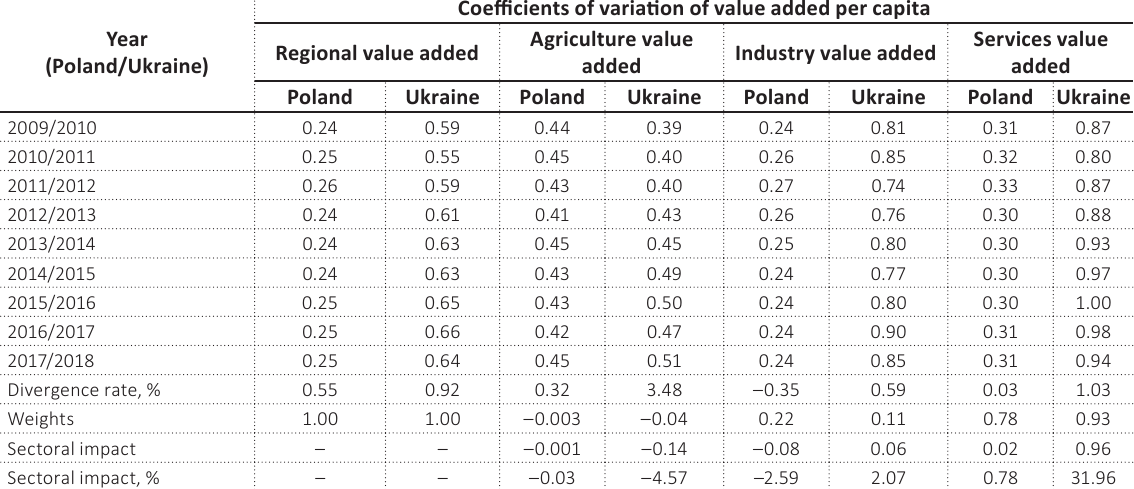
Source: Own calculations.